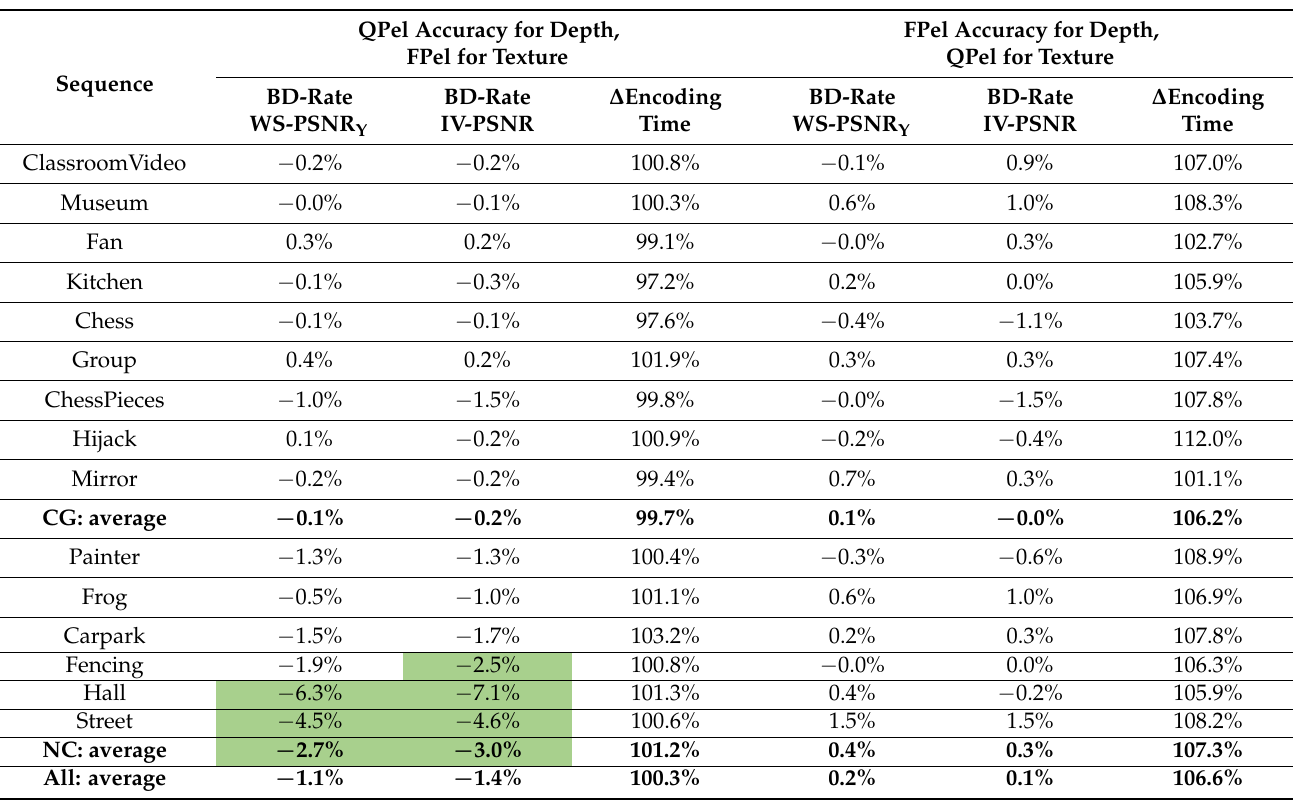
Table 3. Basic SCC vs. SCC with mixed full-pel and quarter-pel IBC accuracy; BD-rates for two